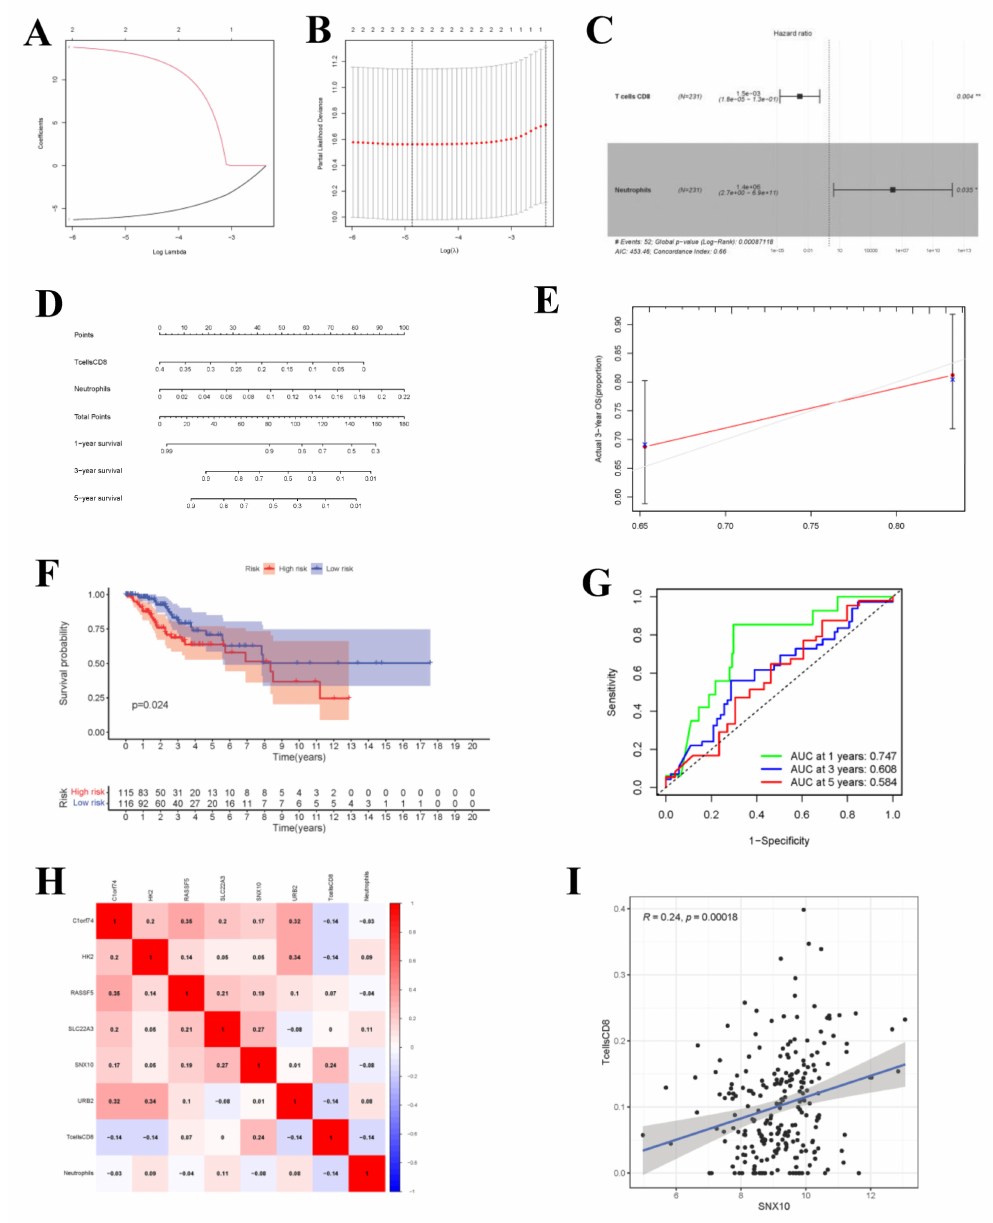
Figure 9. Cox Proportional Hazards Regression Model and Co-expression Analysis. ( A , B ) The results of lasso regression analysis results. ( C ) Forest plot shows prognostic circ-related mRNA signatures of CC. T cells CD8 and Neutrophils were integrated into the Cox proportional hazards regression model (* p < 0.05; ** p < 0.01). The nomogram ( D ) was constructed based on the model. The ROC ( G ) and calibration curves ( E ) indicate the acceptable accuracy (AUCs of 1-year survivals: 0.747) and discrimination of the nomogram. ( F ) OS of patients with high/low-risk score. ( H ) The co-expression heatmap of the RNAs and immune cells in the two Cox proportional hazards regression models; the significant results of Pearson correlation coefficients between the RNAs and immune cells: T cells CD8 and SNX10 ( I